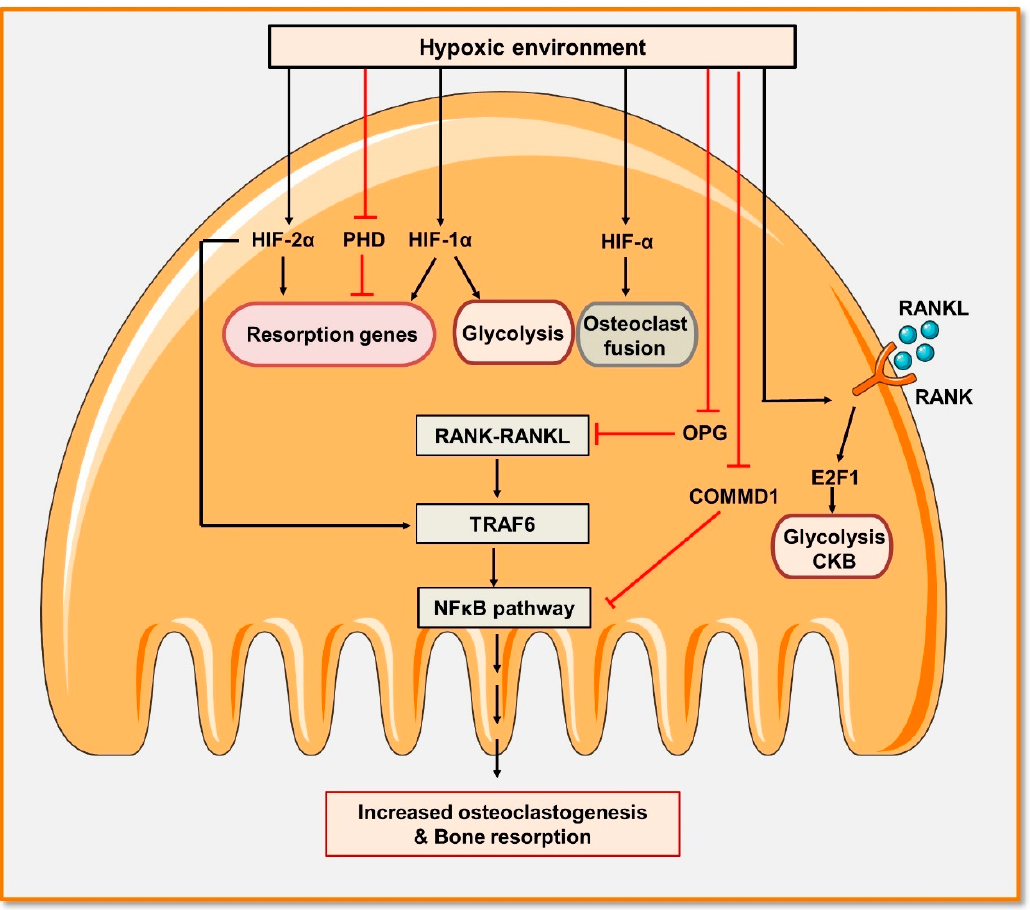
Figure 4. Hypoxia promotes osteoclast differentiation and bone resorption: Osteoclastogenesis is accelerated in hypoxic circumstances. Hypoxia-inducible factors 1 α and 2 α (HIF-1 α and HIF-2 α ) promote the fusion of osteoclasts. HIF-2 α also promotes the expression of TRAF6, enhancing the activation of the NF- κ B signaling pathway and maturation of osteoclasts. In addition, hypoxia promotes the activation of NF- κ B by reducing the expression of osteoprotegerin (OPG). HIF-1 α and HIF-2 α , as well as the inhibition of the prolyl hydroxylase domain (PHD), stimulate the production of pro-resorptive genes. Additionally, HIF-1 α is important in promoting glycolytic activity either directly or via negatively regulating the expression of the copper metabolism domain containing 1 (COMMD1) gene. Hypoxia also activates RANK-RANKL signaling that, by promoting the expression of elongation transcription factor (E2F), induces glycolysis and thus enhances the differentiation of osteoclasts along with its induced bone resorption activity.